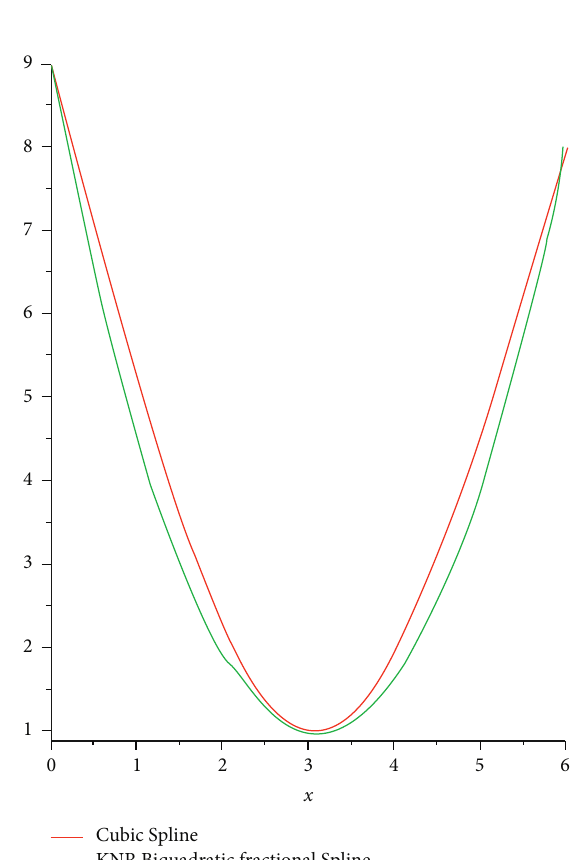
Figure 13: Piecewise curves can be manipulated by the choice of shape parameters 1.